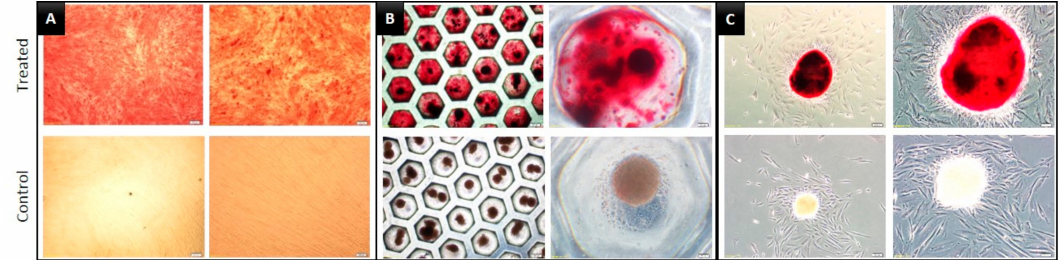
Figure 4. Images of dental pulp stem cells (DPSCs) induced to undergo osteogenic di ff erentiation for 20 days and stained with Alizarin Red S. ( A ) 2D, ( B ) SF, and ( C ) ULA group, respectively.